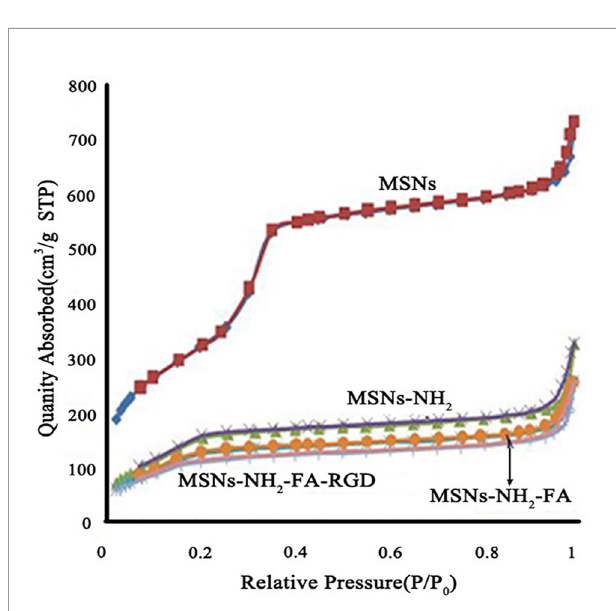
FIGURE 4 | Nitrogen adsorption-desorption isotherms of MSNs, MSNs-NH 2 , MSNs-NH 2 -FA, and MSNs-NH 2 -FA-RGD.